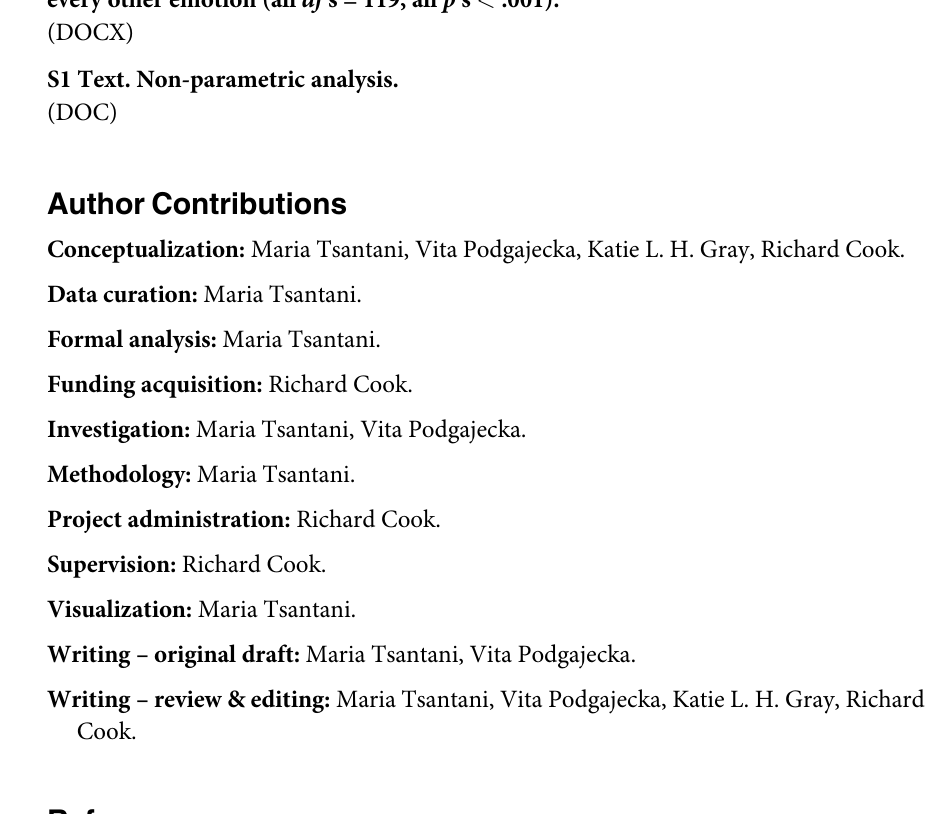
S1 Table. Results of t-tests for neutral faces comparing intensity ratings of sadness with every other emotion (all df ’s = 119, all p ’s <